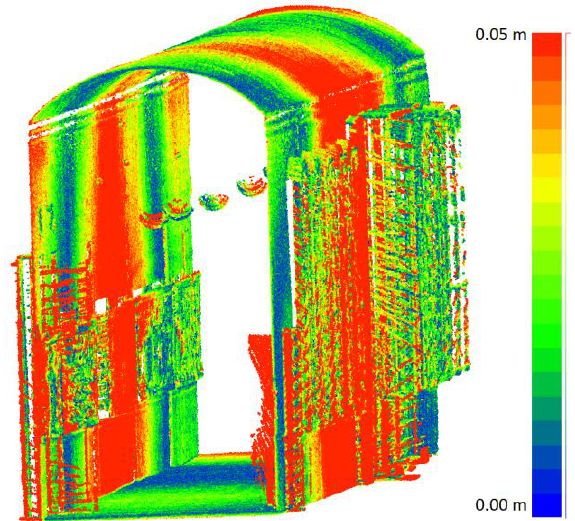
Figure 11 Cloud to cloud (NavVis and Leica) computation (3D) results in CloudCompare (long corridor) This effect occurs mainly because the lack of constraints and the accuracy of the SLAM alignment drops down. To avoid this problem, the NavVis uses anchor points which can be also measured with total stations to enhance the accuracy of the instrument.